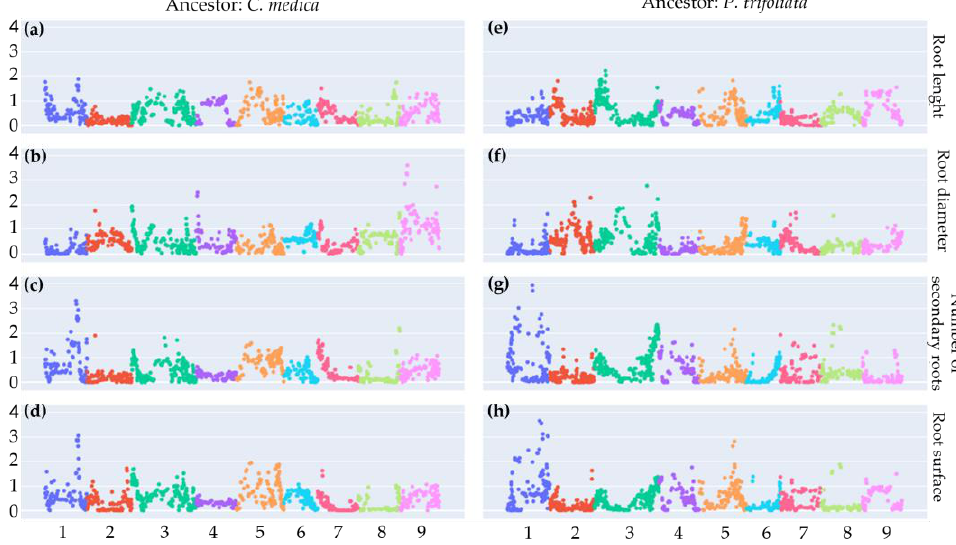
Figure 6. Evaluation of the association between ancestors doses in diploid gametes and root traits. Manhattan plots from GLM procedure: X axis: position on the nine P. trifoliata chromosome; Y axis: − log 10 ( p -value); ( a , e ): root length, ( b , f ): root diameter, ( c , g ): number of secondary roots, ( d , g ): root surface. ( a – d ): C. medica doses in Volkamer lemon gametes. ( e – h ): P. trifoliata allelic doses in Swingle citrumelo gametes.